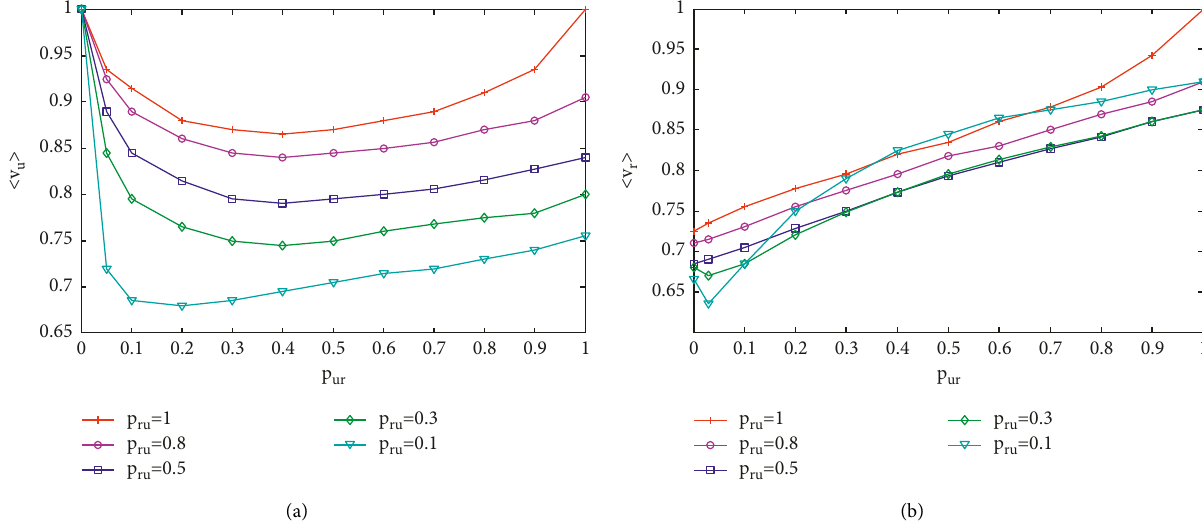
Figure 4: When ρ � 0.3 and L � 100, (a) the relationship between the average velocity of upward vehicles and p between the average velocity of right-moving vehicles and p ur , with different p ru